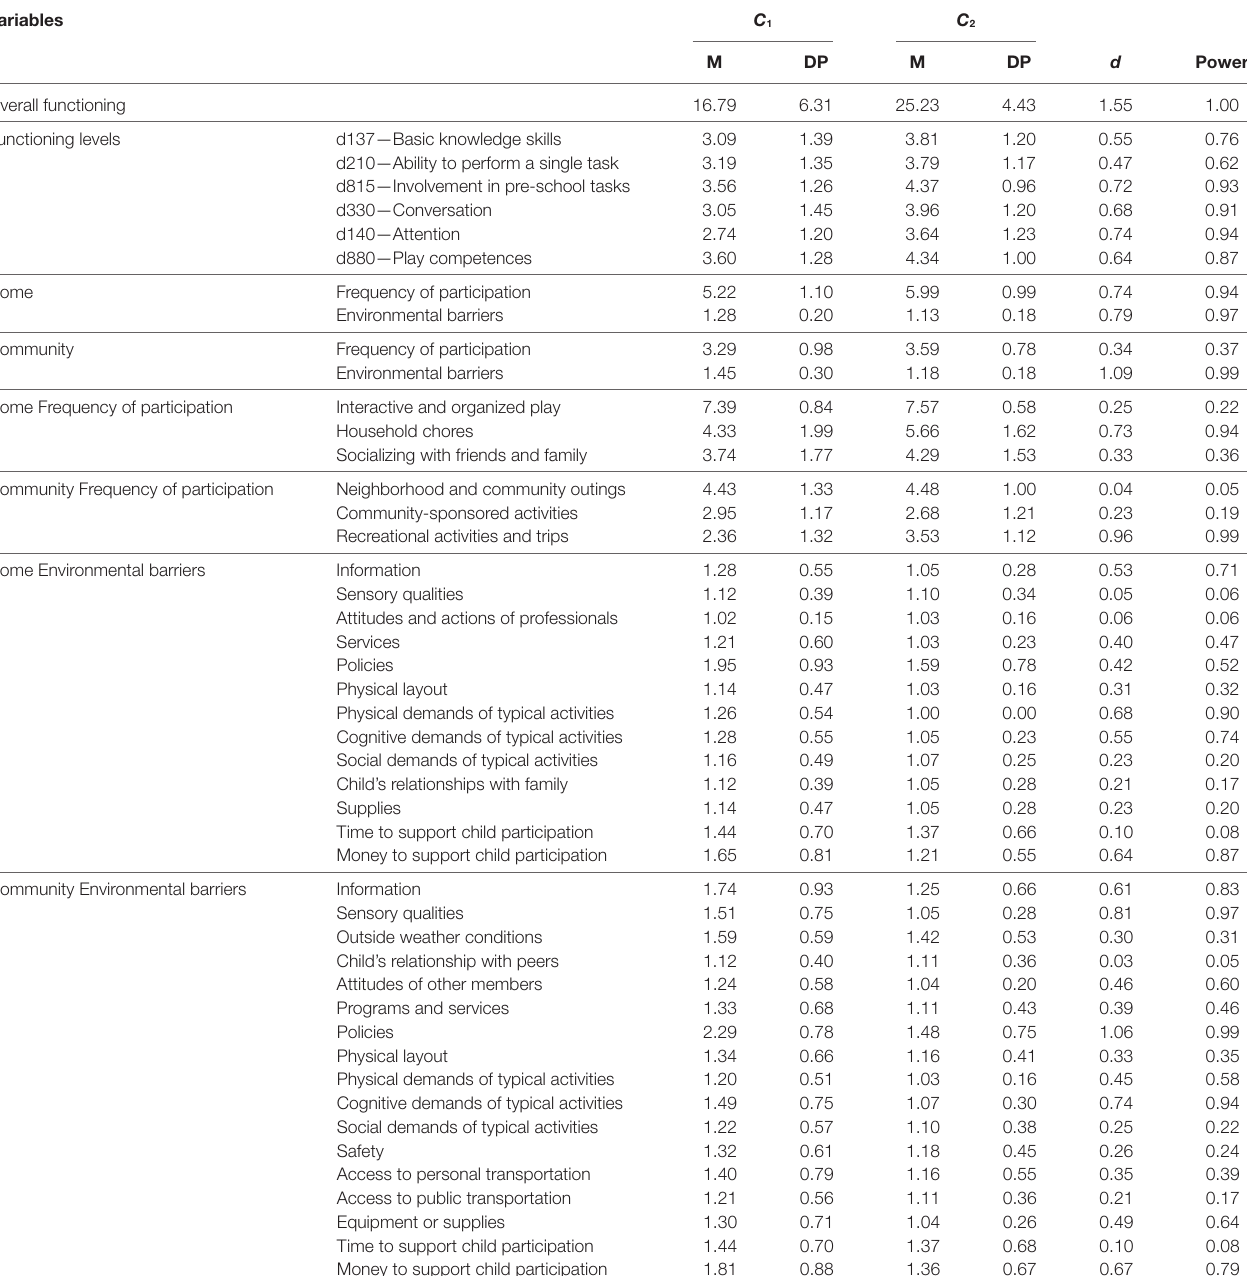
TaBle 1 | Post hoc power